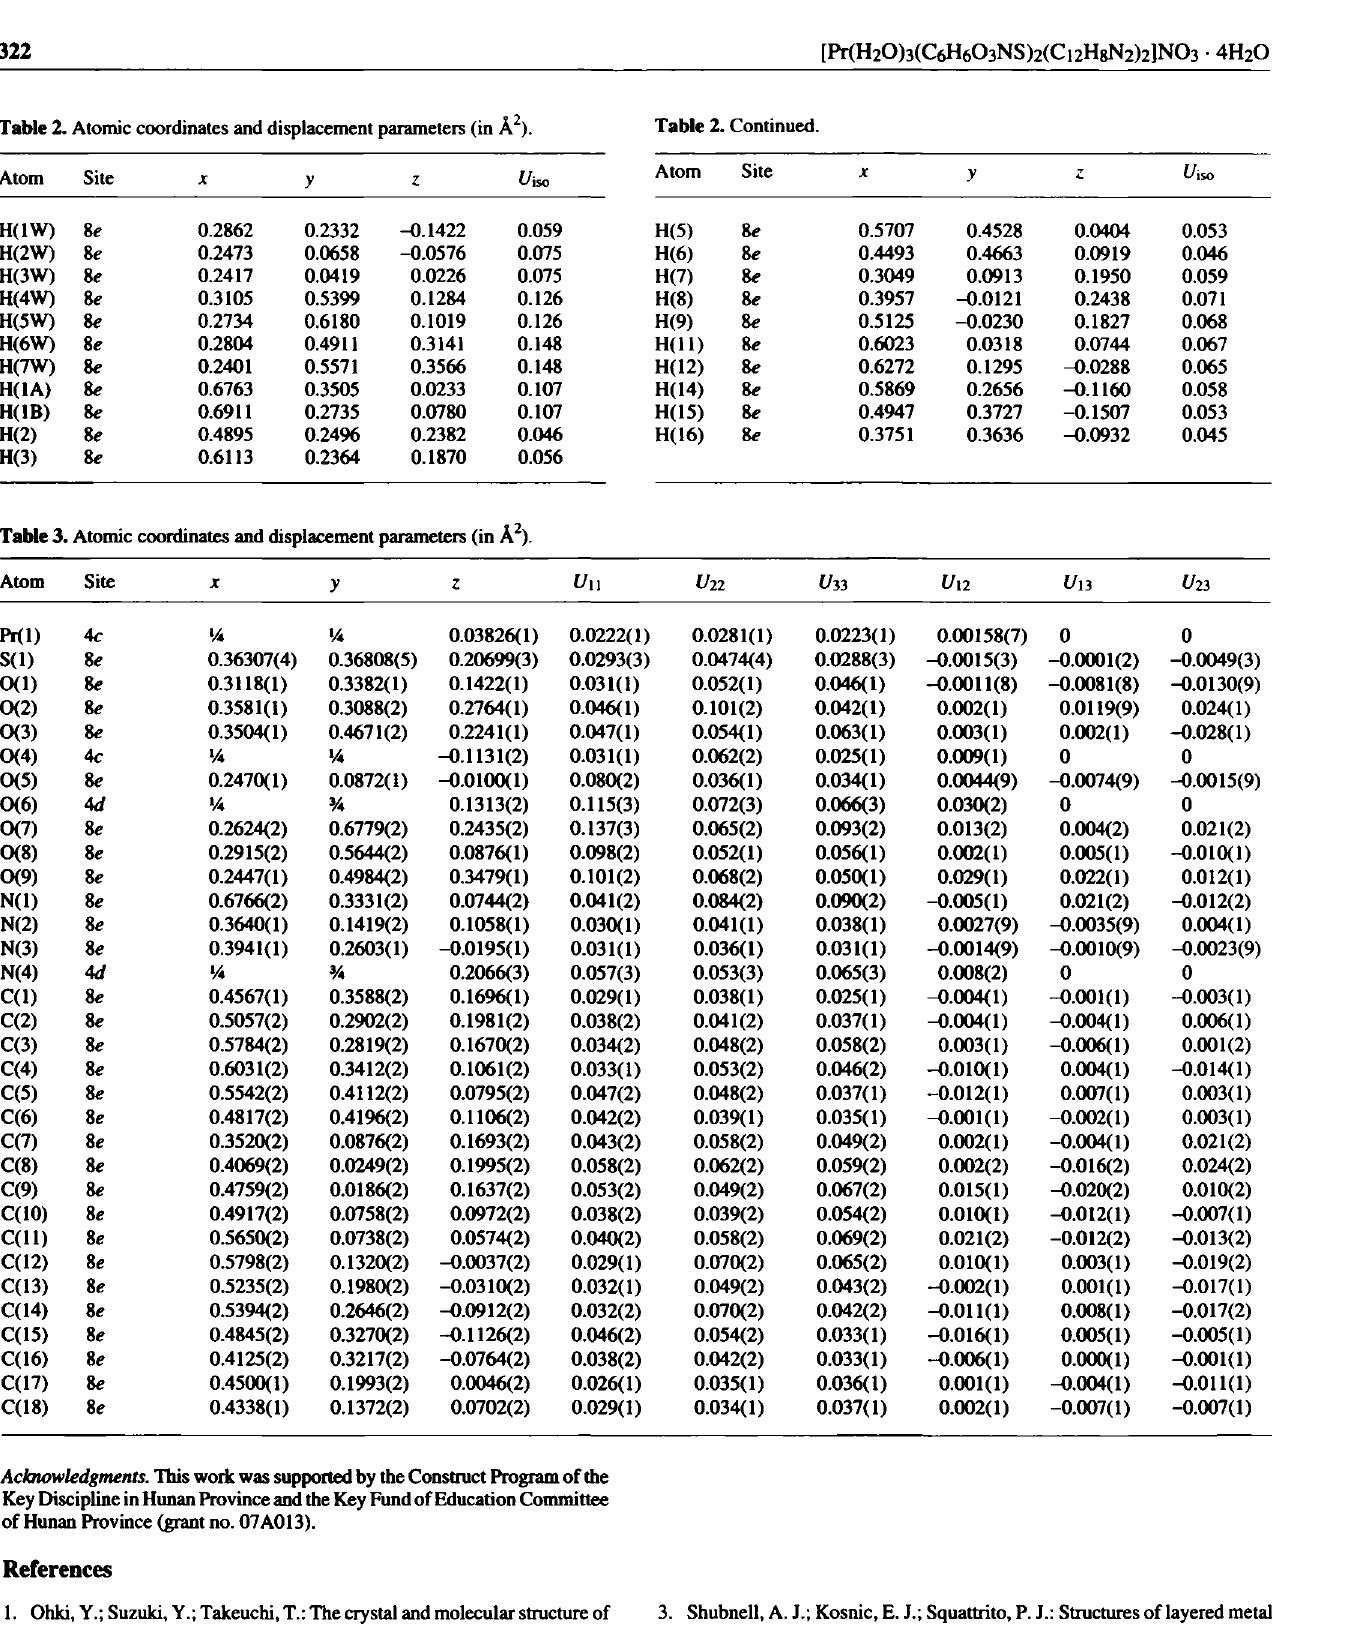
Table 2. Atomic coordinates and displacement parameters (in Â 2 ).